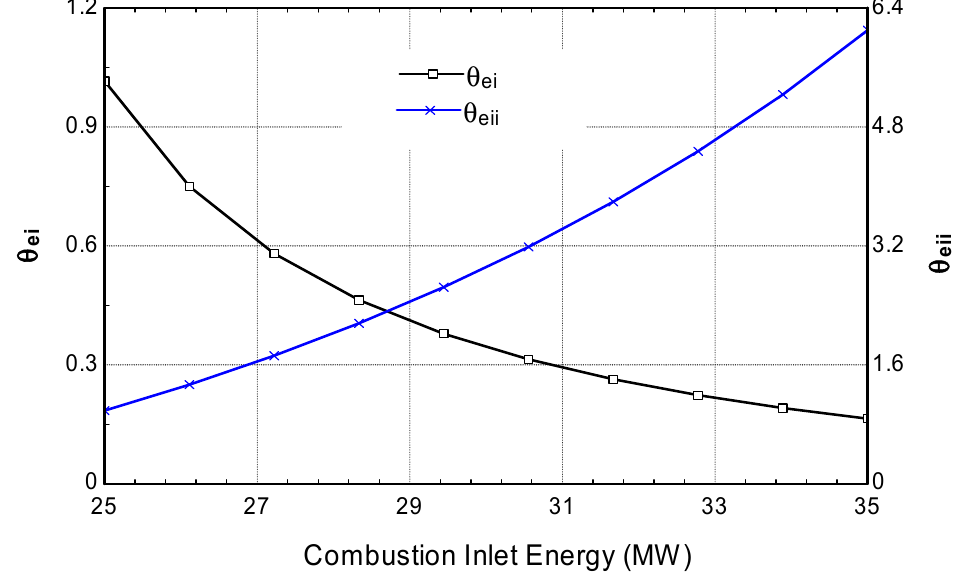
Figure 8. Impact of varying the combustion inlet energy rate on the environmental impact index and the environmental impact factor of the overall system.